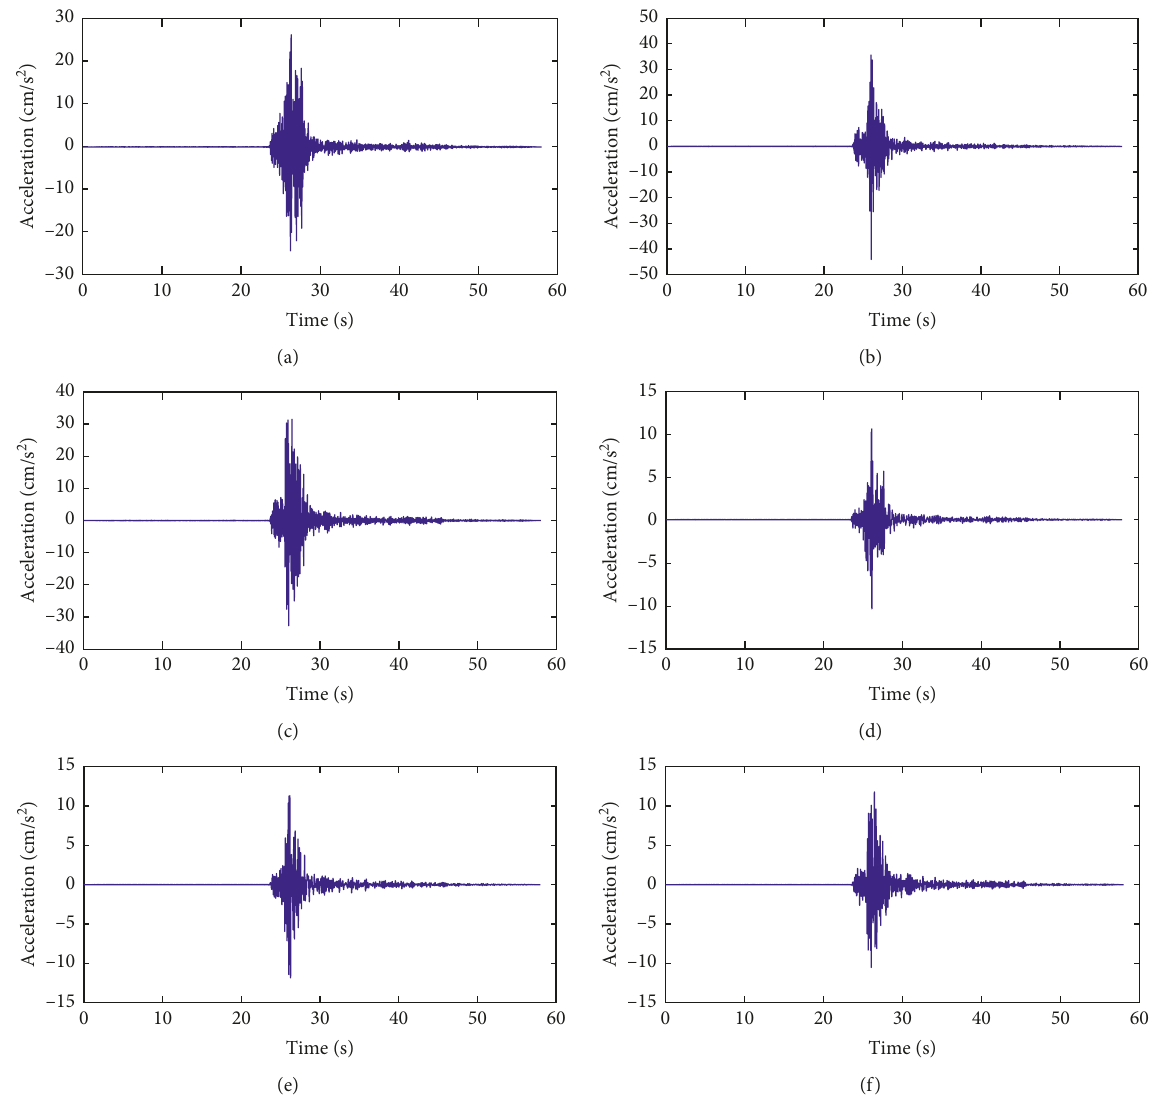
Figure 15: Strong motion of Pacoima arch dam of channels in the radial direction during the Newhall earthquake: (a) channel 1; (b) channel 2; (c) channel 5; (d) channel 6; (e) channel 7; (f) channel 8. Table 3: Some time-invariant modal identification results of the Pacoima dam.